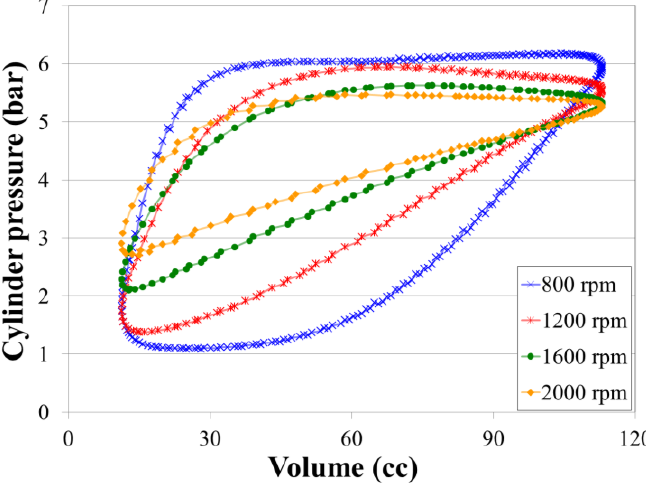
Figure 7. P-V diagram acquired during experiments at 6 bar and different rotation